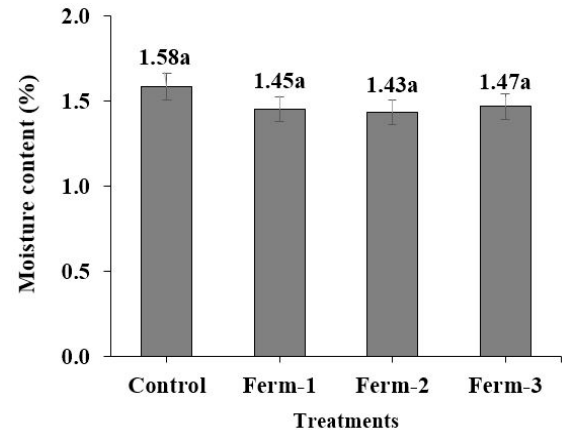
Figure 3. The average of moisture contents (24 h and 48 h) of fermented ground roasted coffee with different yeasts. The bars with the same letters indicate non-significant difference ( p > 0.5) among treatments.